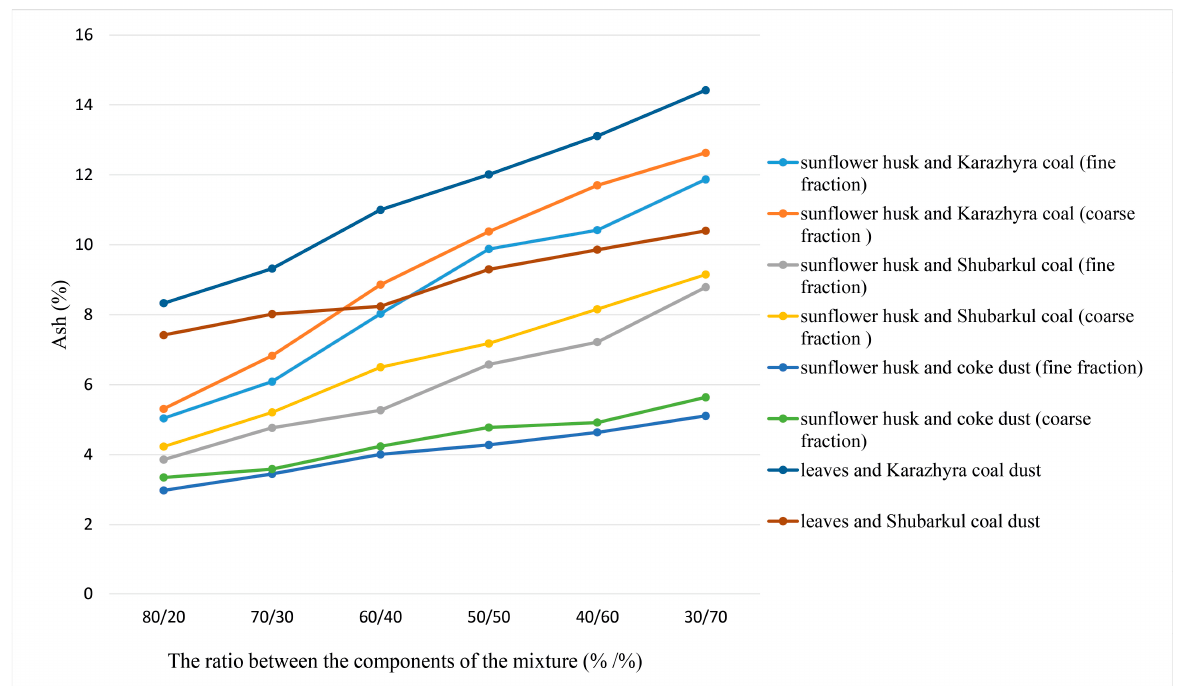
Figure 2. Change in ash content depending on the type and ratio of the components of the bio- coal